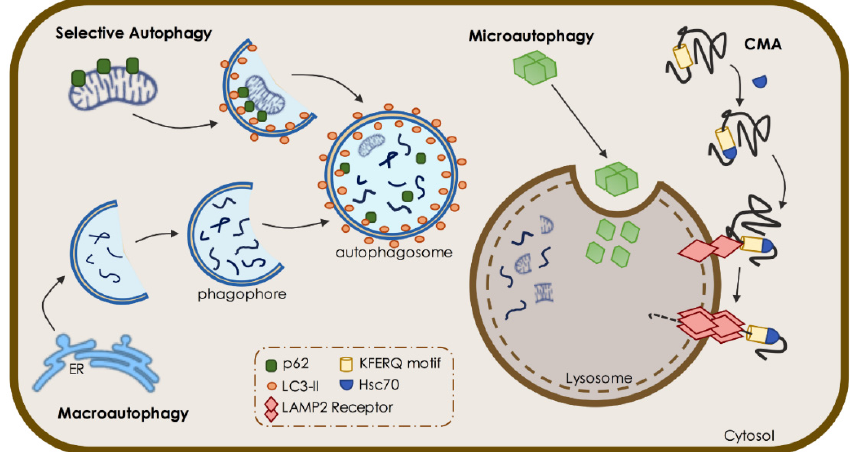
Figure 1. Different types of autophagy. Selective autophagy and macroautophagy initiates with phagophore formation. Through a series of chain reactions, the phagophore sequesters its materials into a double-membrane to form the autophagosome, which, in turn, docks and fuses with the ly- sosome. In microautophagy, the cargo is directly internalized through invagination of lysosomal and endosomal (not shown) membranes. The chaperone-mediated autophagy (CMA) initiates with recognition of cytosolic proteins carrying KFERQ consensus pentapeptide motifs by the cytosolic HSC70 chaperone and translocation to the lysosomal membrane through binding with lysosomal- associated membrane protein type-2A (LAMP2), resulting in cytosolic protein internalization and